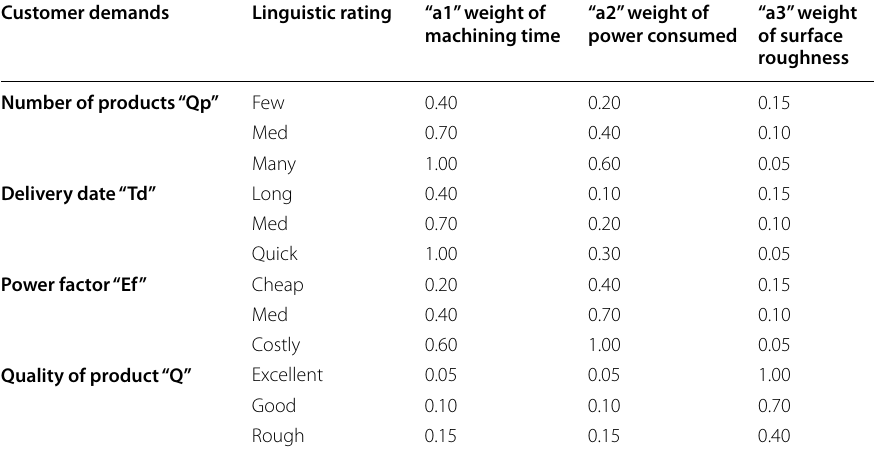
Table 1 Data results from the expert